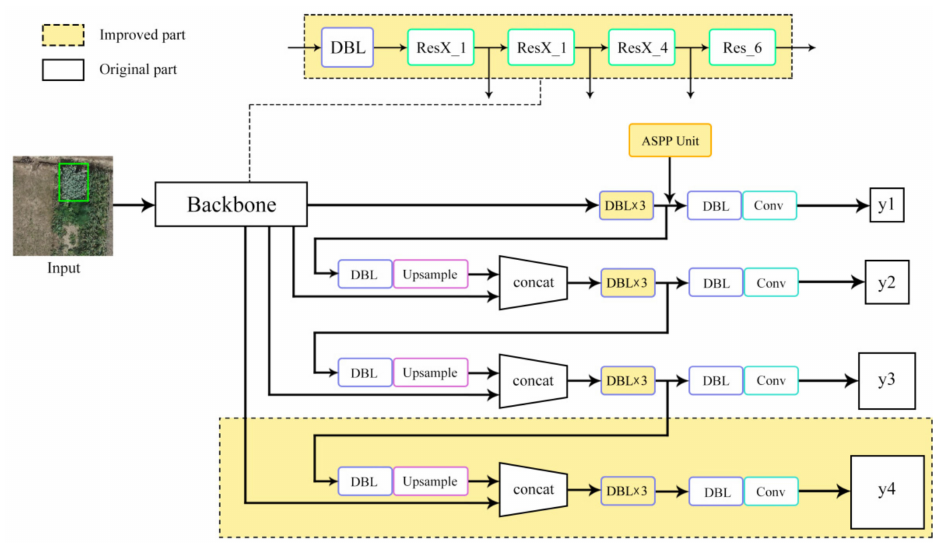
Figure 5. Global MultiScale-YOLOv3 network structure.